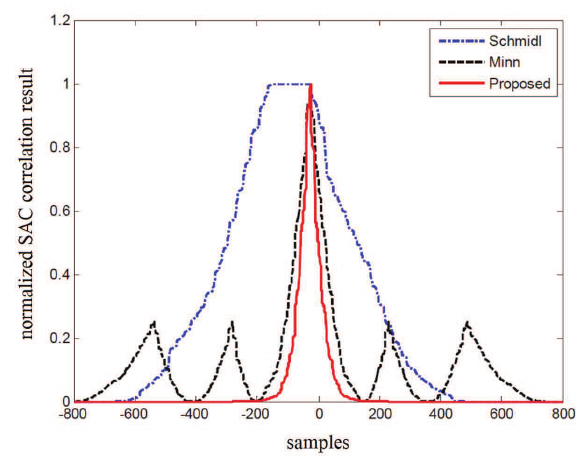
Figure 4. Comparison for timing peaks of three